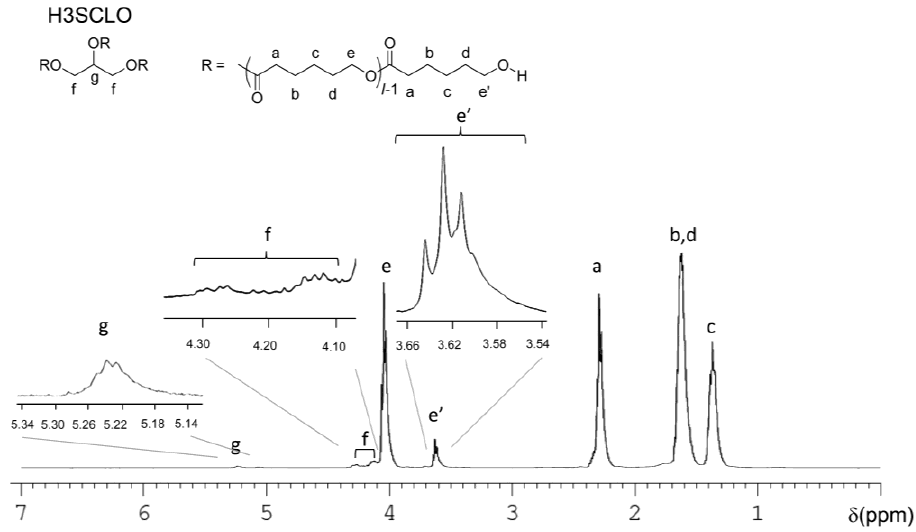
Figure 2. 400 MHz 1 H-NMR spectrum of H3SCLO in CDCl 3 .